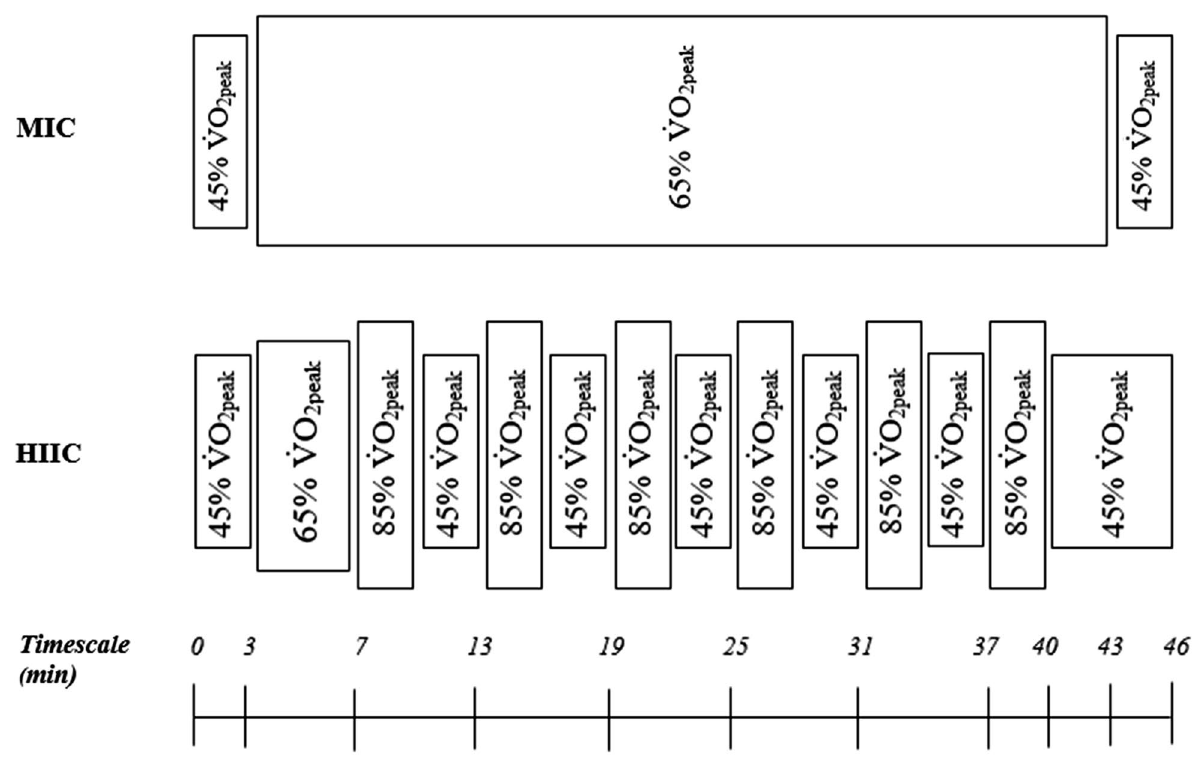
Figure 3. Schematic of the work and duration-matched MIC and HIIC protocols, forming the endurance exercise element of the acute exercise stimulus. MIC moderate intensity cycling; HIIC high intensity interval